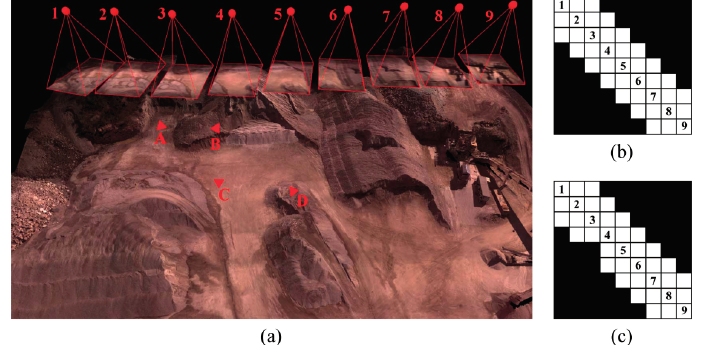
Figure 14. ( a ) Experiment to assess the effect of imaging configuration; ( b ) Connectivity matrix in OverlapTest 1; ( c ) Connectivity matrix in OvelapTest